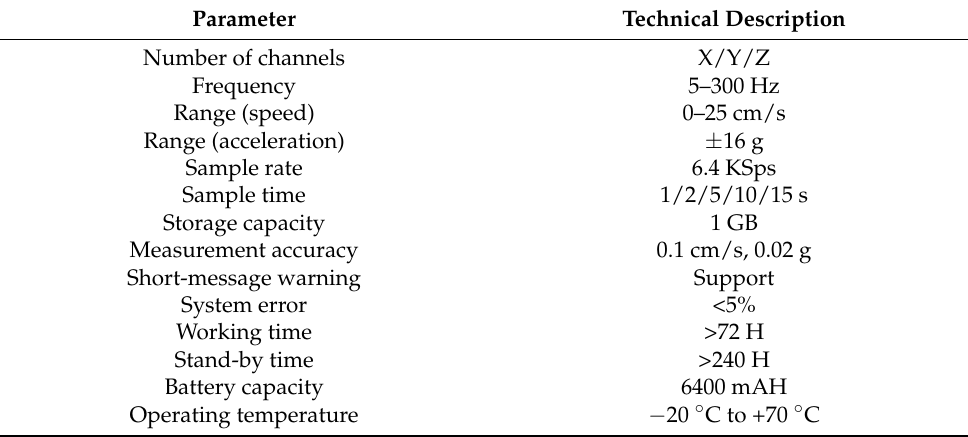
Table 1. The parameters of the TC-6850. Parameter Technical